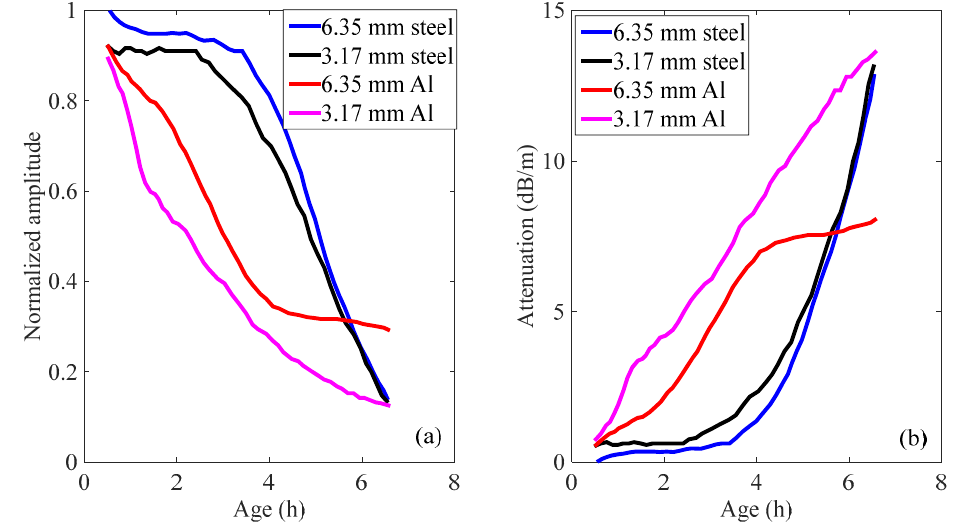
Figure 5. Waveforms at 0.5, 2.0, 4.0, and 6.0 h for a mortar sample with w/c = 0.40 using: ( a ) a steel rod of 3.17 mm diameter; ( b ) an aluminum rod of 3.17 mm diameter.